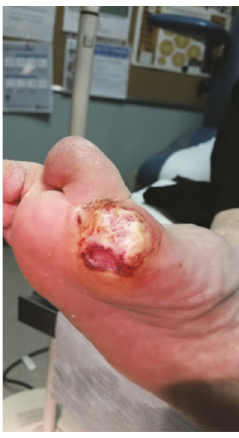
Figure 1: Exophytic lesion at the base of the first MTP joint of the right foot within a chronic diabetic ulcer. Pathology confirmed this lesion to be verrucous carcinoma.